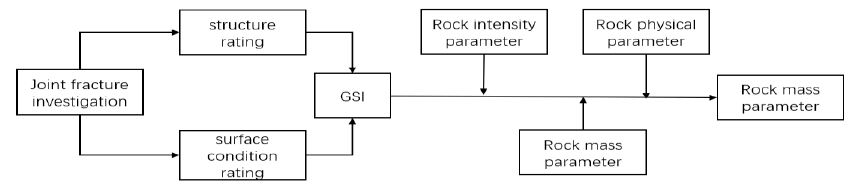
Figure 2. Process of parameter reduction method to obtain rock mass parameters.